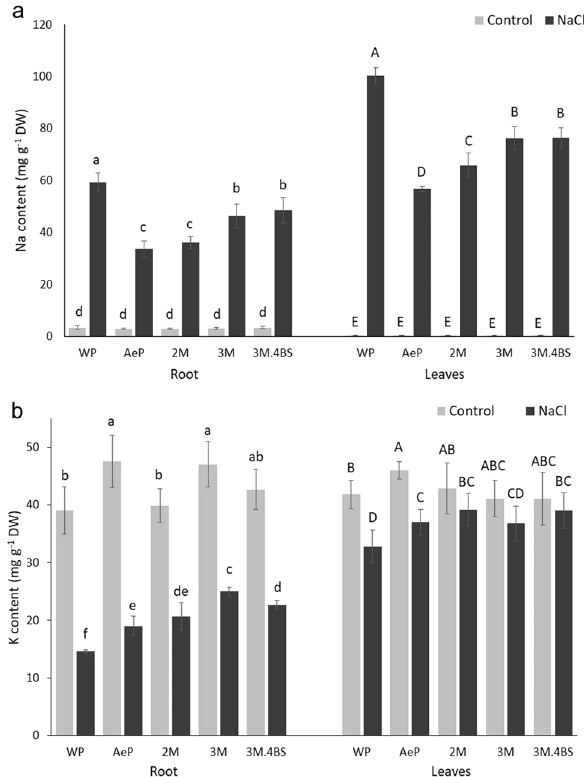
Figure 7. Na ( a ) and K ( b ) contents of roots ( left ) and leaves ( right ) of different genotypes grown in hydroponic solution with and without NaCl. Data are mean ± standard deviation of three replicates per treatment. Different letters indicate significant differences between the genotypes at p < 0.05 using Tukey’s post hoc